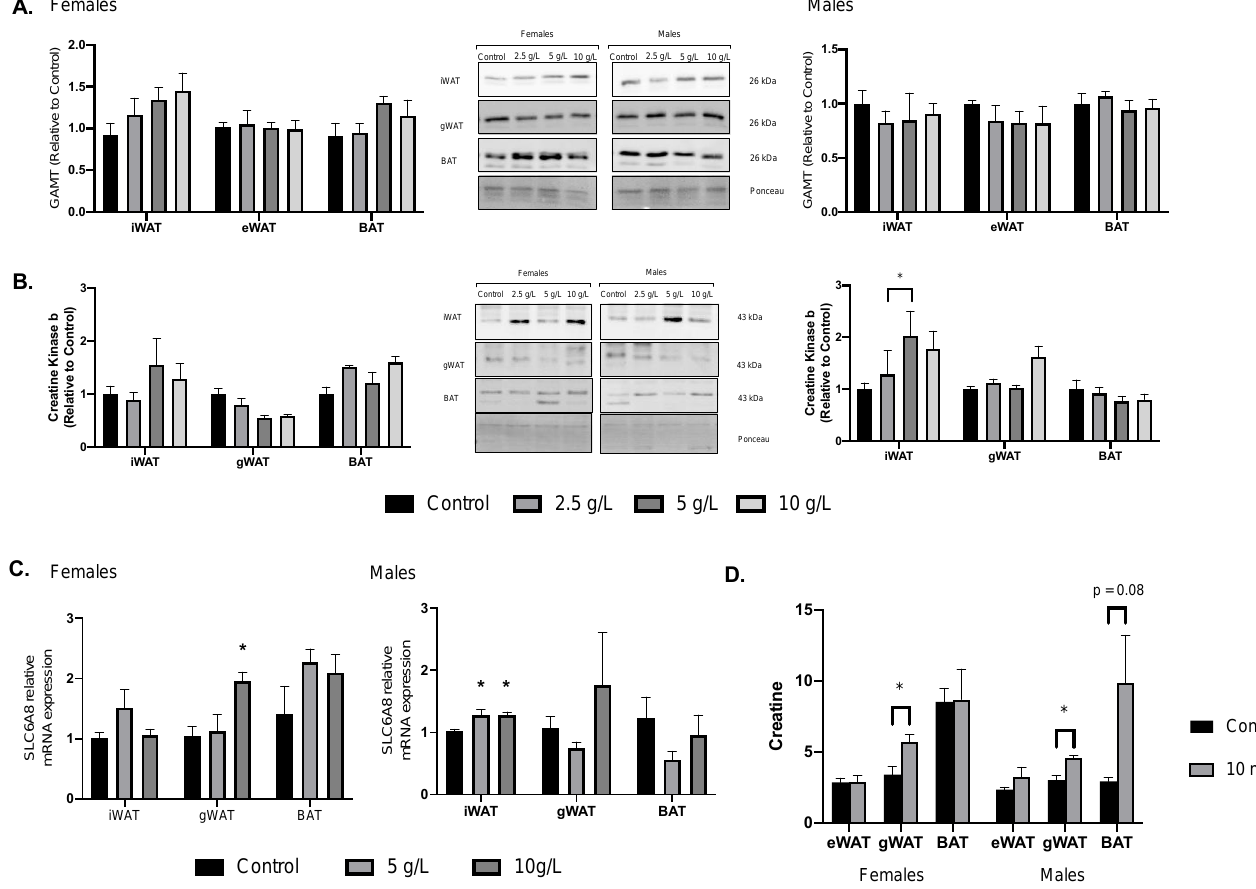
Figure 4. Adipose tissue markers of creatine uptake and metabolism. ( A ) Adipose tissue depot GAMT protein content in female (left) and male (right) rats. ( B ) Creatine kinase B content. ( C ) Slc6A8 mRNA expression. ( D ) Creatine content. Data were analyzed by ANOVA and are presented as mean ± SEM, * denotes significantly different from control group, p < 0.05.